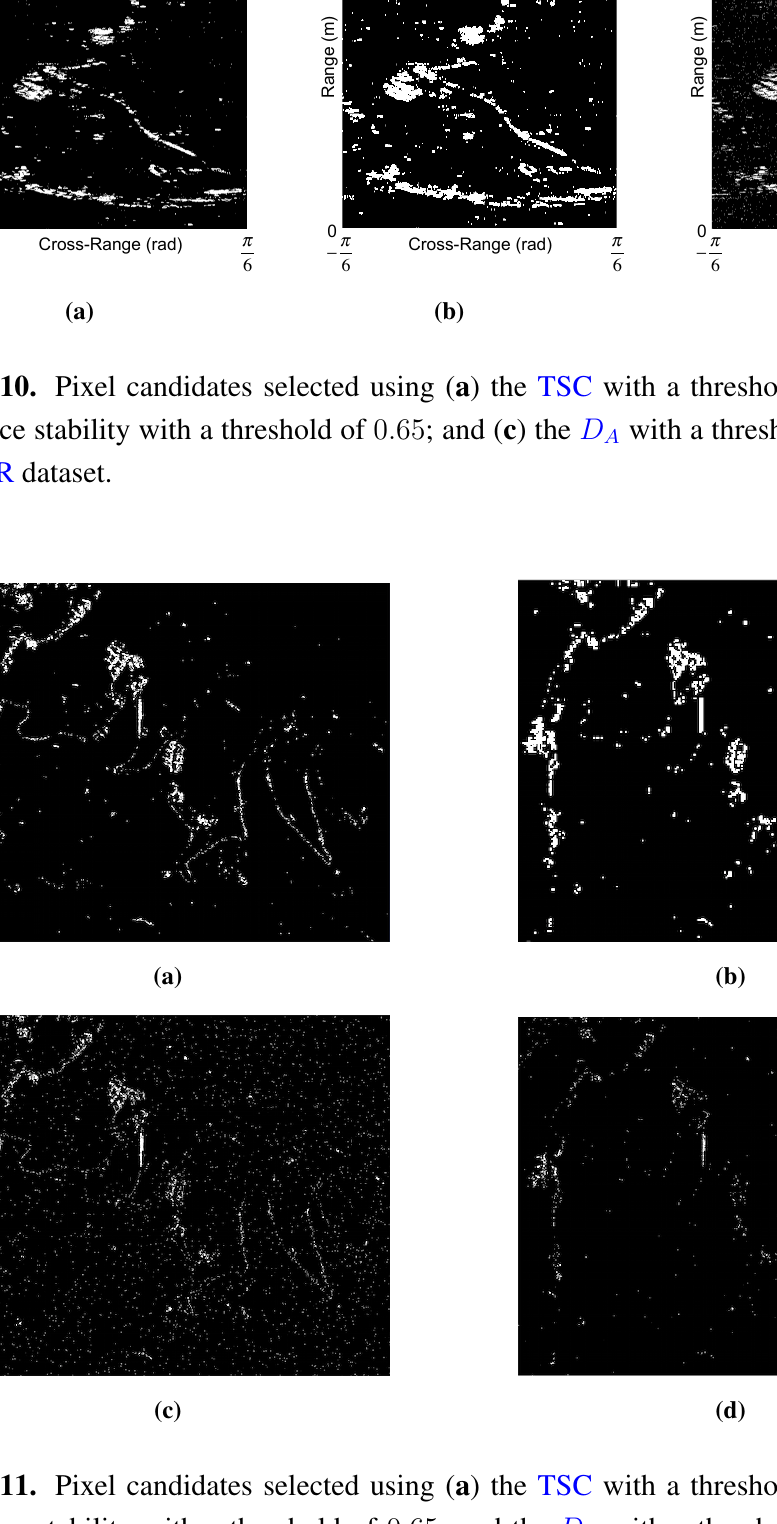
with a threshold ( c ) of 0 . 25 and A